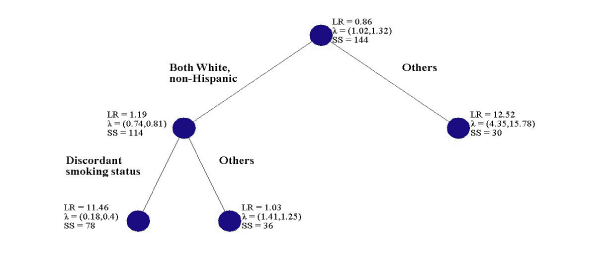
Final tree for D2S2275 (SS, sample size).